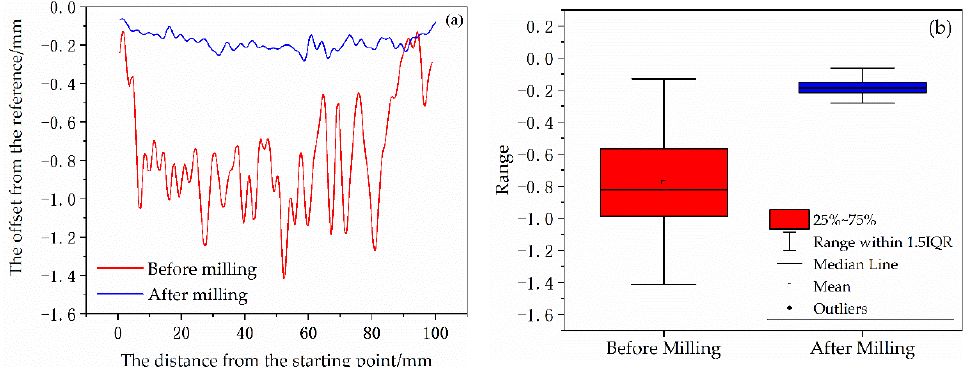
Figure 22. ( a ) The third principal stress contours after side milling of thin-walled parts; and ( b ) Y component normal stress contour after side milling of thin-walled parts.